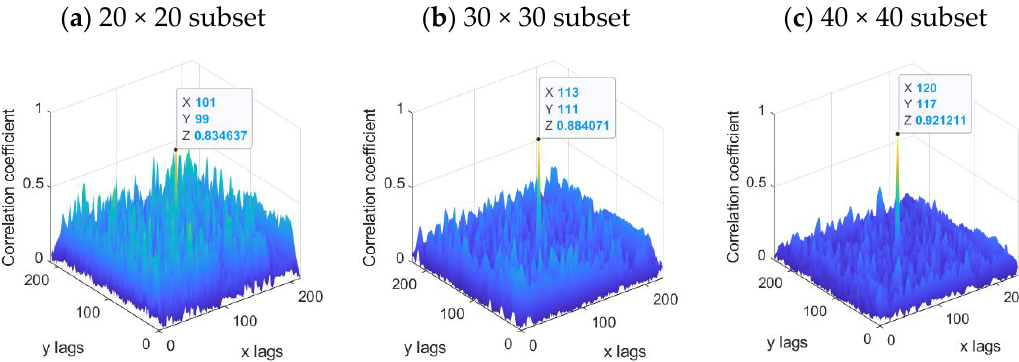
Figure 7. Distribution of the cross-correlation coefficients for three different subset sizes: ( a ) 20 × 20 subset, ( b ) 30 × 30 subset and ( c ) 40 × 40 subset.